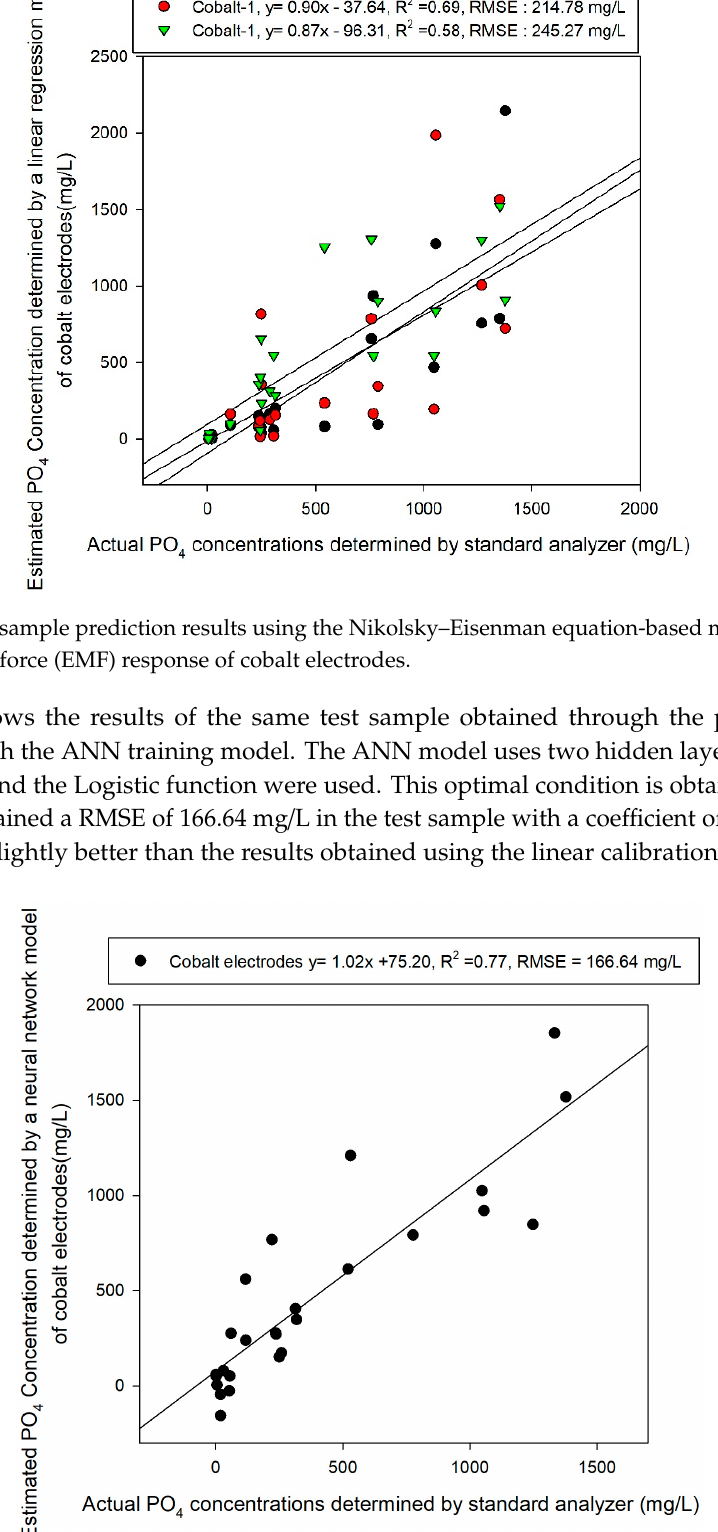
Figure 5. Calibration plot for linking a cobalt-electrode response to PO 43- concentrations.